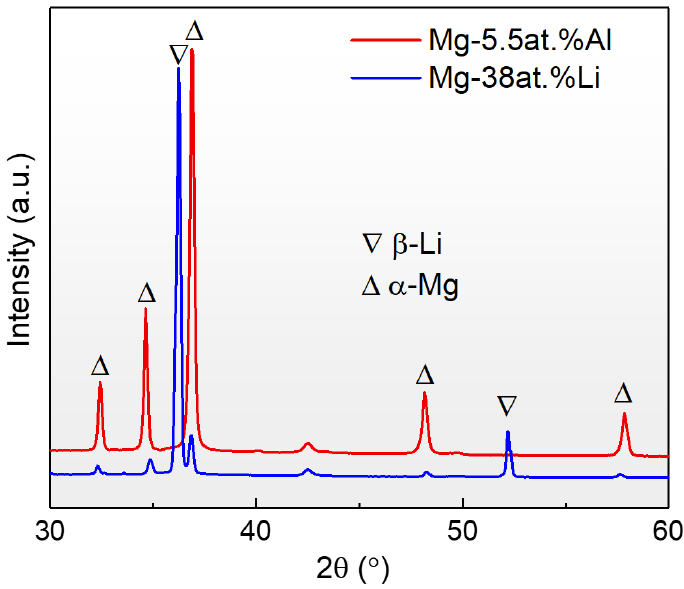
Figure 2. X-ray diffraction profile of solution-treated Mg–38at.%Li and Mg–5.5at.%Al. Mg–5.5at.%Al is made up of single HCP α phase, and a single BCC β matrix with minor α phase is achieved in Mg–38at.%Li.